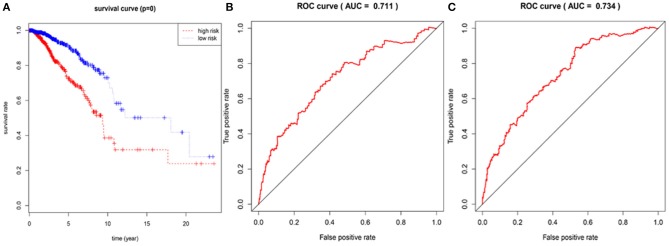
Assessment of prognostic risk in 1,076 breast cancer patients using an 7-lncRNA model, the Kaplan-Meier curve showed a poor prognosis in the high-risk group (A). Time-dependent ROC curve analysis of 7-lncRNA model for survival prediction of breast cancer patients, ROC curve predicting 3 years survival rate (AUC = 0.711) (B); ROC curve predicting 5 years survival rate (AUC) = 0.734) (C).